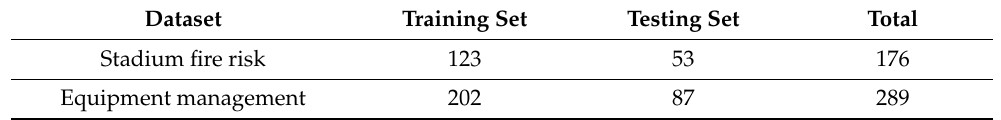
Table 2. Distribution of stadium fire risk data and equipment management